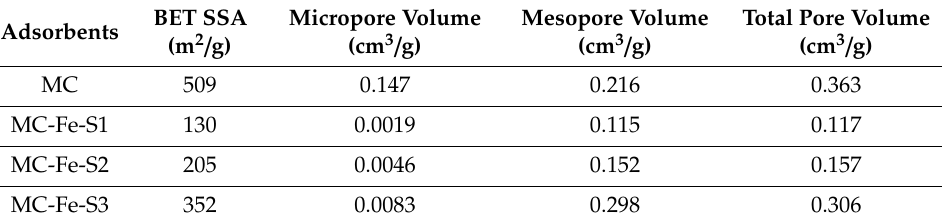
Figure 2. N 2 adsorption – desorption plots at 77 K ( a ) and pore size distributions ( b ) of iron and sulfur dual-doped carbons. obtained by nonlocal density function theory (NLDFT). Inset of Figure 2b shows micropore distribution. Table 1. Pore textural properties of mesoporous carbons.